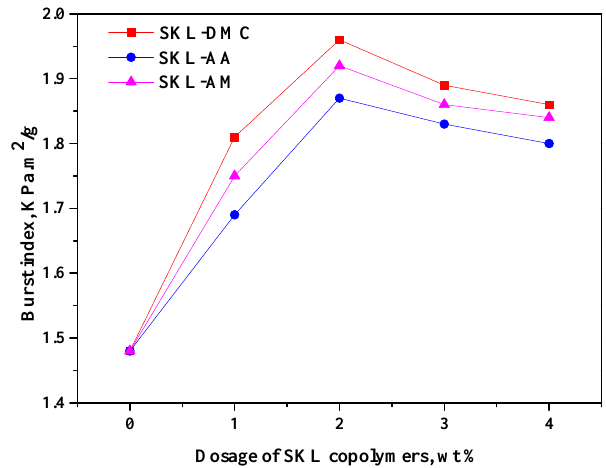
Figure 7. Burst index of paper sheets with various amounts of three additives added (SKL-DMC, SKL-AA, and SKL-AM).